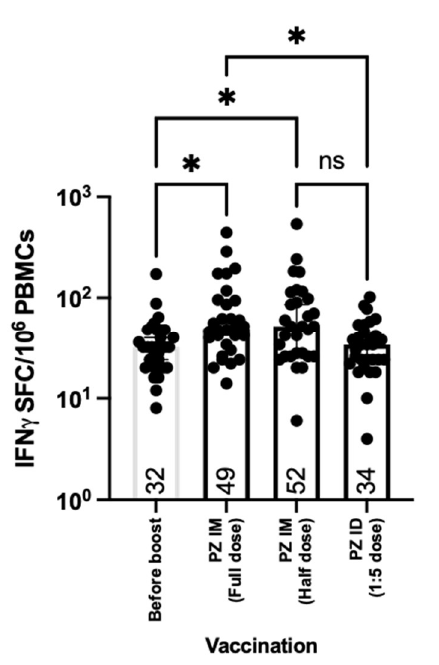
Figure 5. T cell responses after boosting. All volunteers were previously vaccinated with two doses of inactivated SARS-CoV-2 vaccines (SV SV). The fractional dose (1/5 dose) of the mRNA vaccine was injected intradermally, as a booster dose (SV SV PZ ID). Full doses and half doses of the mRNA vaccine were immunised intramuscularly as a standard route of injection (SV SV PZ IM). Blood was drawn before (D0) and after the booster dose for 14 days (D14). The blood samples were processed to obtain PBMCs. The fresh PBMCs were stimulated with S1 peptide pools, before measuring IFN- γ secreted cells, using ELISpot. Each symbol represents one participant, and the number is the median of each group ( n = 30–31 volunteers). Statistical significance was determined using the Kruskal–Wallis test, with Dunn’s multiple comparisons test. *, p ≤ 0.05; ns = non significance.